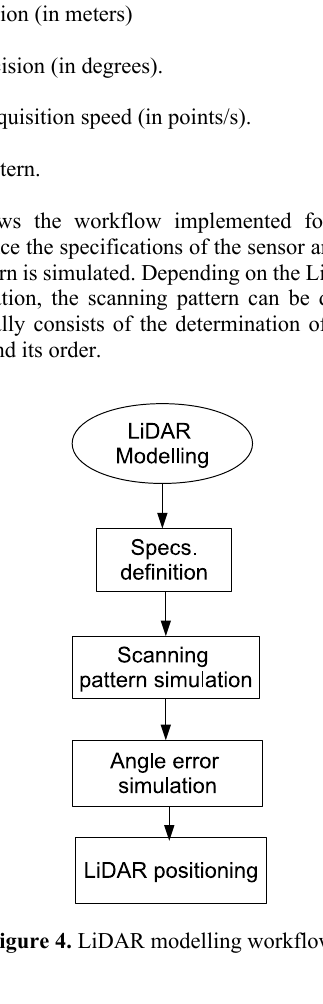
Once the LiDAR and the satellite are defined and positioned (Figure 7), the next step is to carry out a ray tracing algorithm with the rays of the scanning pattern, defined in the previous